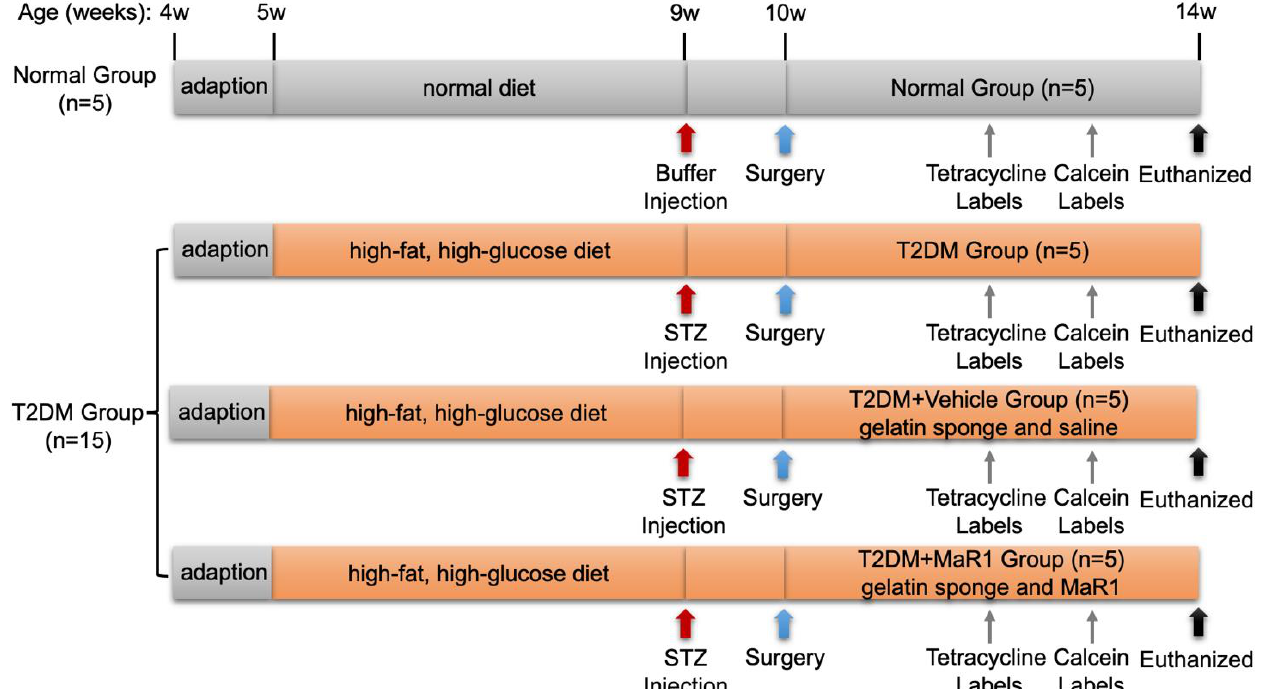
Figure A6. Illustration of the experimental design in vivo. Buffer: sodium citrate buffer; STZ: streptozotocin.